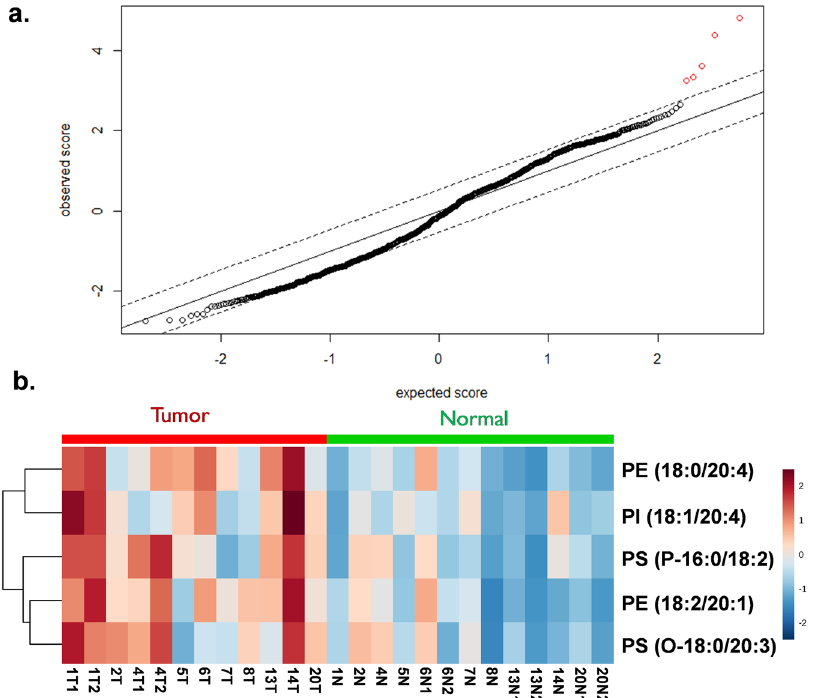
Fig. 4 Multivariate analysis. a Feature extraction using signi fi cance analysis of microarrays (SAM) analysis highlighting fi ve molecules (in red) which represent the most distinguishing features in the tumor compared to normal samples, with a false discovery rate of <0.001 and con fi dence interval of 90%. b The hierarchical map was constructed in an unsupervised and randomized manner, resulting in a heat map demonstrating relative differences in ion intensities of the 5 features between tumor and normal samples.